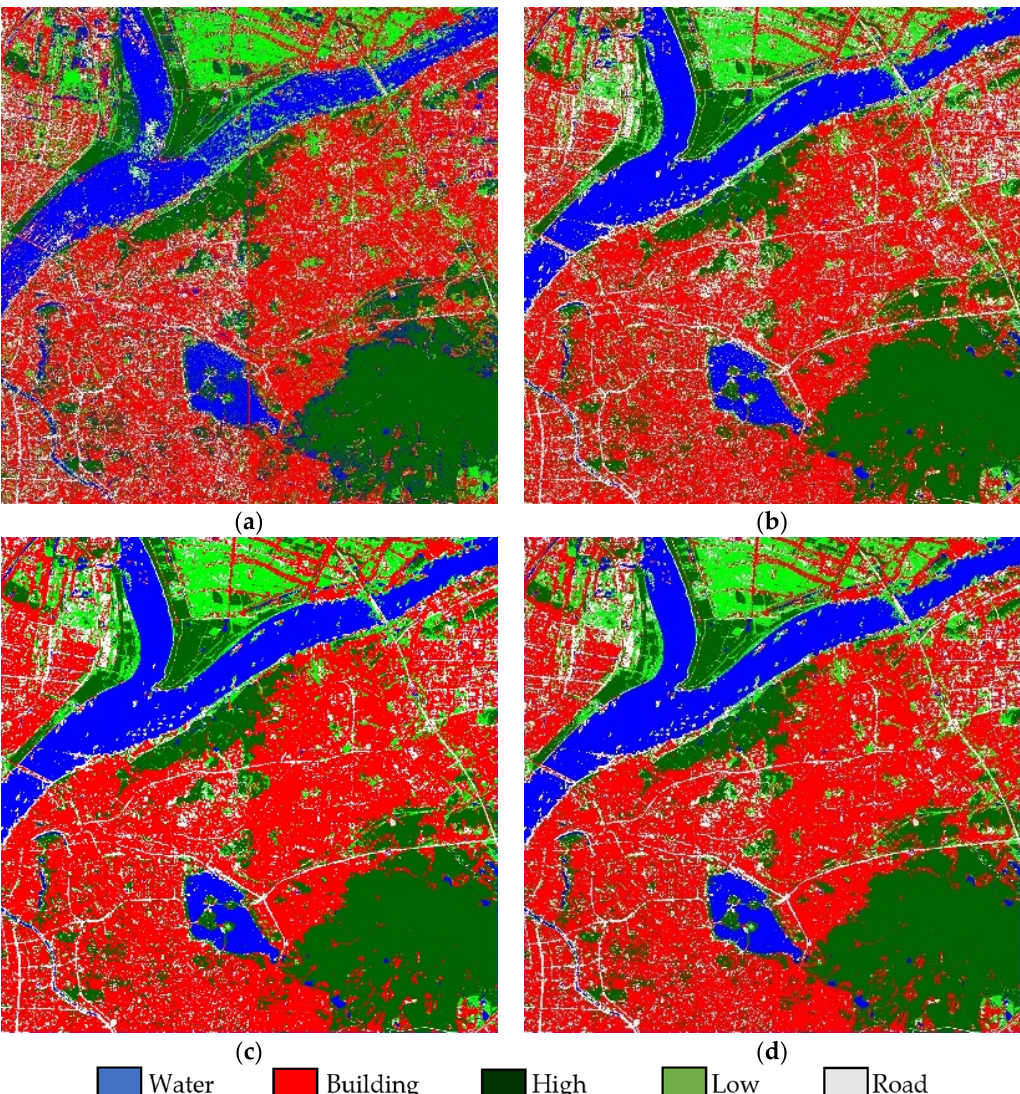
Figure 4. Classification results with different classifier ( a ) SVM classifier result, ( b ) RF classifier result, ( c ) RF-CRF model result, and ( d ) RF-Im_CRF model result.